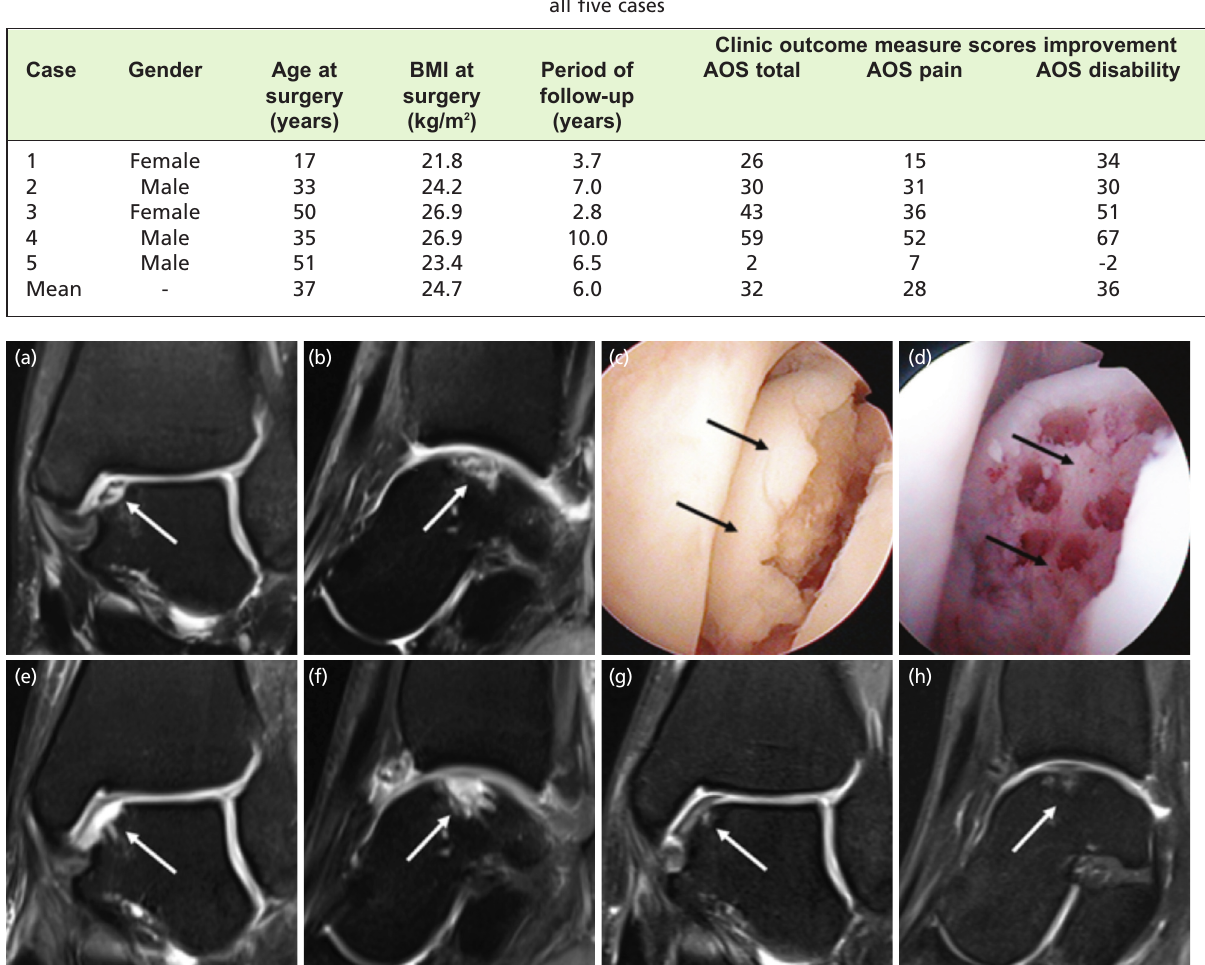
Fig. 1: (a) Coronal and (b) sagittal MRI of the left ankle showing osteochondral lesion at the medial aspect of the talar dome (white arrows) from case 1. (c) Arthroscopic view over the medial aspect of the left ankle joint, showing the loose osteochondral fragment (black arrows). (d) View after removal of the osteochondral fragment followed by subchondral drilling (black arrows). MRI of the left ankle performed one day after surgery, with (e) coronal and (f) sagittal views following removal of the loose osteochondral fragment and subchondral drilling (white arrows) without bone grafting. Corresponding images at 2 years, (g) and (h) showing repair and regeneration of the bone and cartilage components (white arrows). These are fat-suppressed proton density-weighted MR